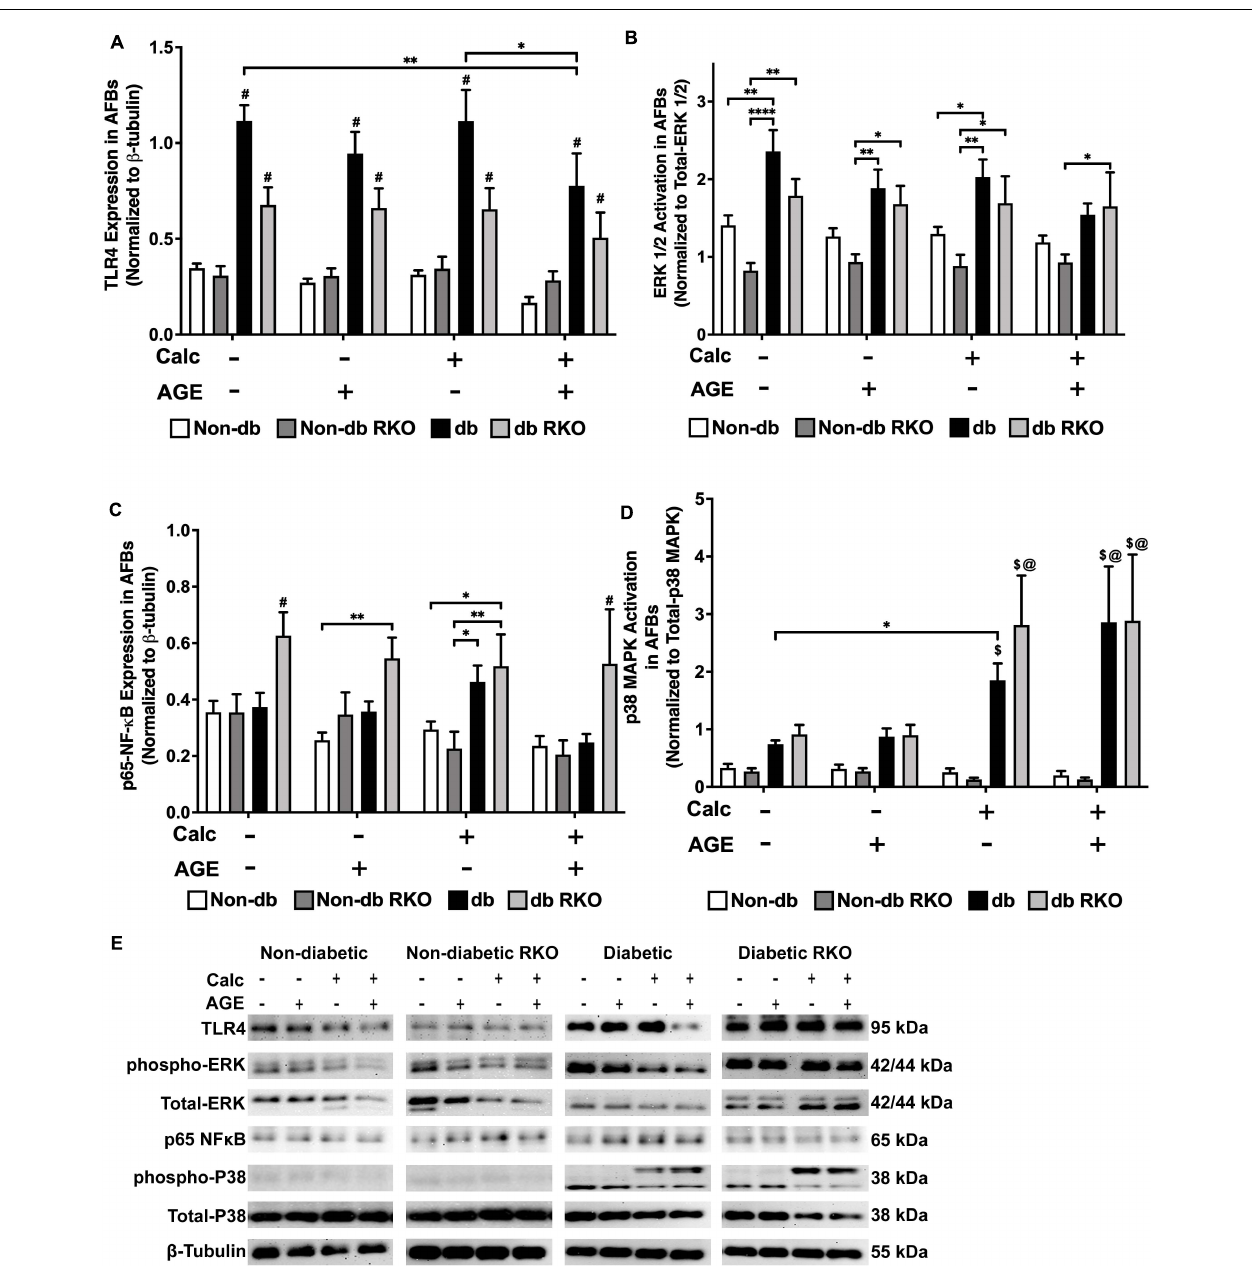
FIGURE 7 | Adventitial fibroblasts may signal through the p38 MAPK/RAGE-axis in response to calcification. Protein expression of TLR4 (95 kDa; A ), activated ERK 1/2 (42/44 kDa; B ), phosphorylated-p65-NF- κ B (65 kDa; C ), and activated p38-MAPK (38 kDa; D ) was quantified. Non-diabetic, non-diabetic RKO, diabetic, and diabetic RKO primary AFBs were isolated and treated with 3 mM P i with or without AGEs (0.5 mg/mL) for 7 days. Protein levels were normalized to β -tubulin (E) and graphed as mean ± SEM with n = 6–9 of independent replicates. Statistical analysis consisted of a two-way ANOVA and a Fisher’s LSD test post hoc ( # p <